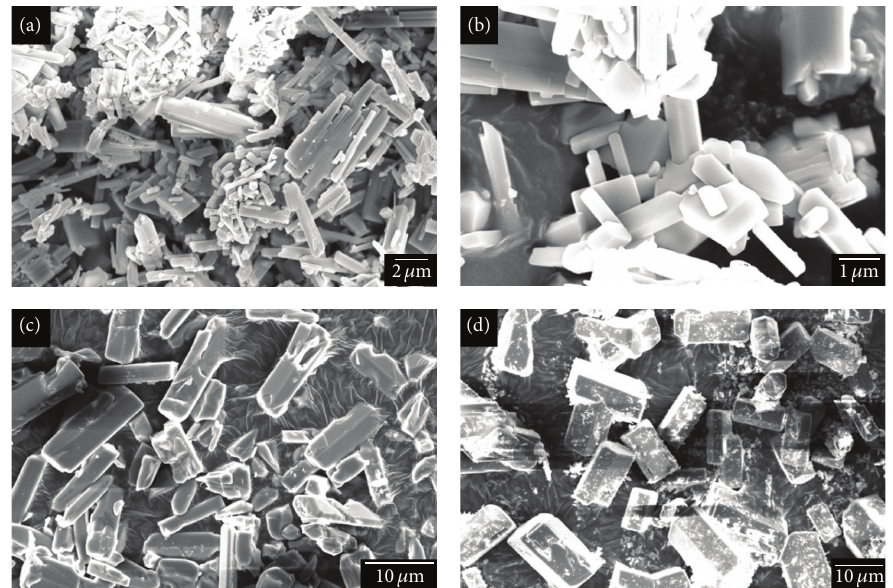
Figure 3: SEM images of LiMnPO 4 using various precursors: (a) sample A, (b) sample B, (c) sample C, and (d) sample D.